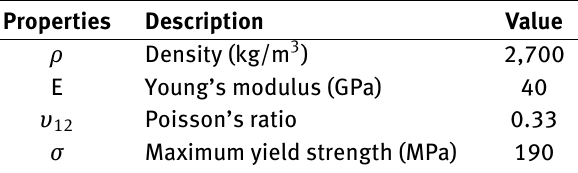
Table 2: Aluminum properties used in FEA